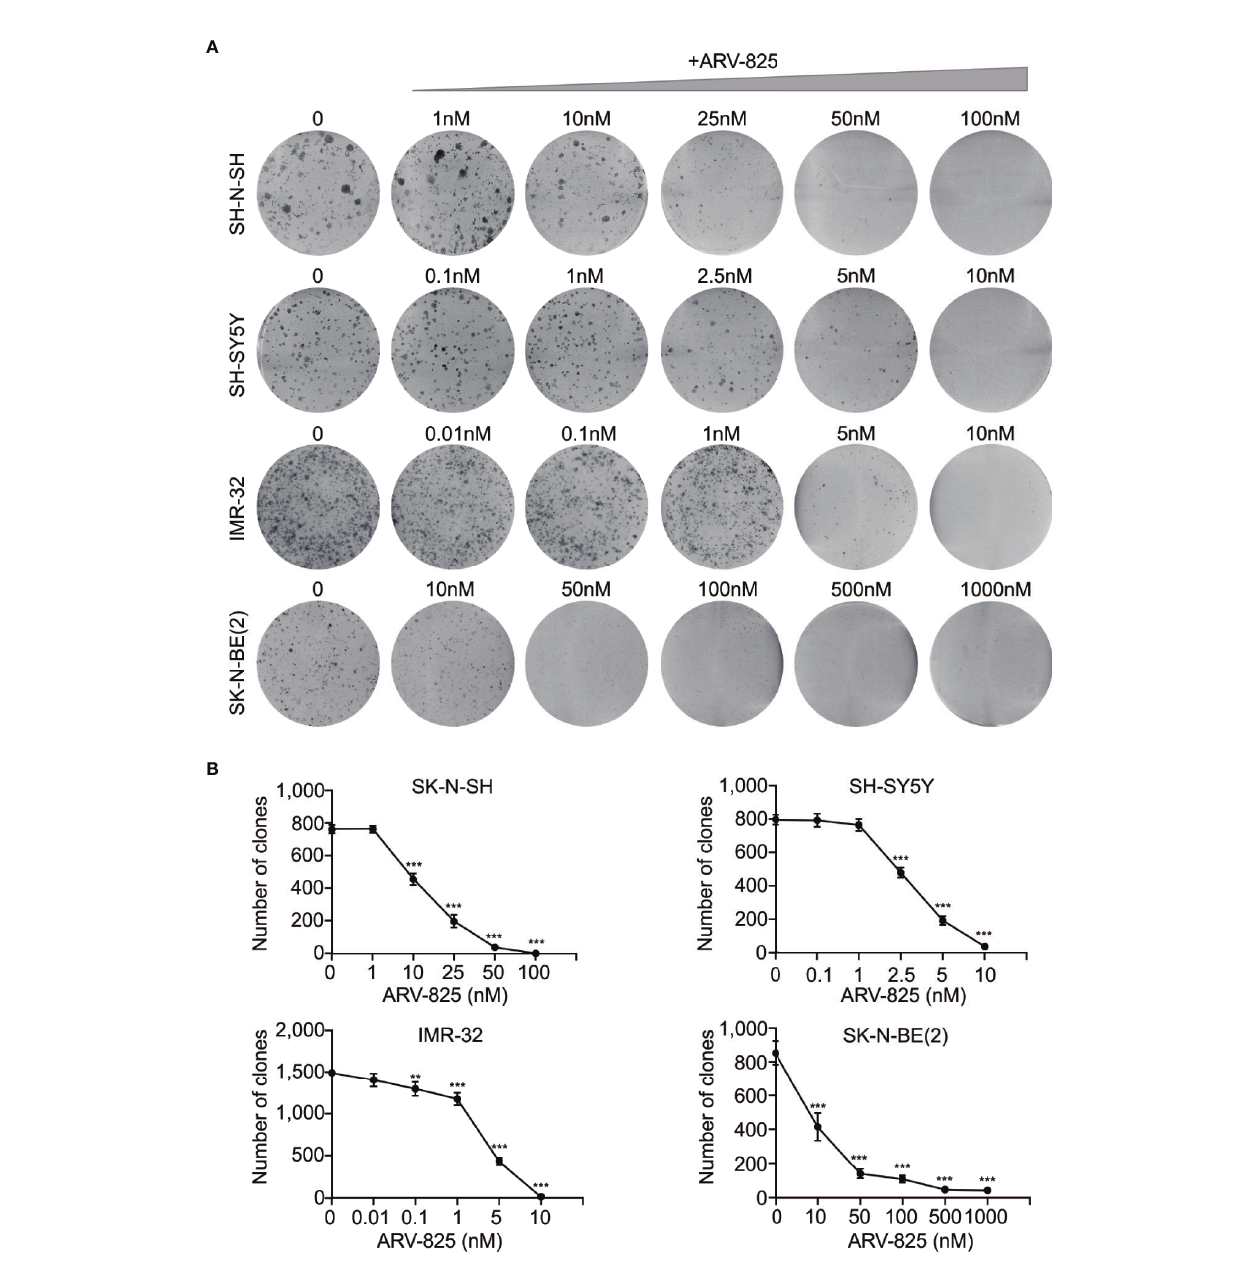
FIGURE 3 | ARV-825 inhibits clonal formation in NB cells. (A) Clone formation assay showed increasing doses of ARV-825 inhibited the clonal formation ability in NB cells. (B) Clone numbers of NB cells treated with increasing doses of ARV-825. ** p < 0.01; *** p <